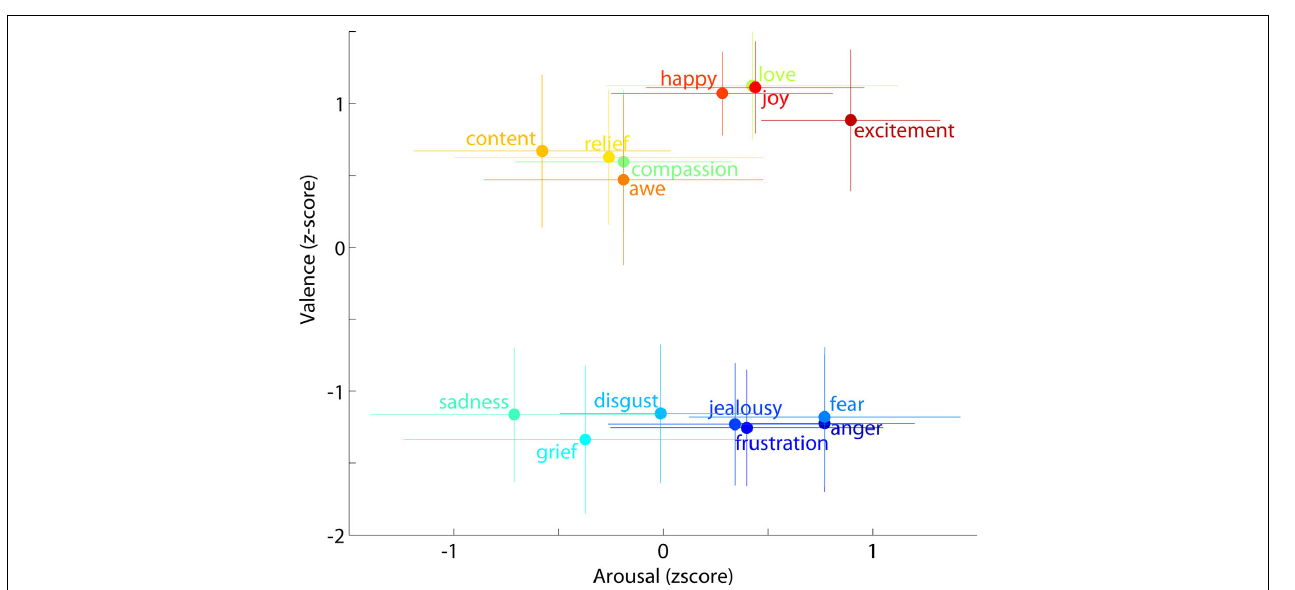
Beta1-4 bands, and Broadband high-frequency activity, respectively. See Table 1 legend for frequency-band limits. Most time course correlations were quite weak, but were typically positive between all lower-frequency IM clusters. Correlations for broadband versus broadband IM pairs (arrow) were more often positive than for any other IM cluster pairs. Correlations of broadband IM time courses with lower-frequency IMs (ellipse) tended to be negatively correlated, though nearly all IM time course correlations were weak (| r | < 0.4).